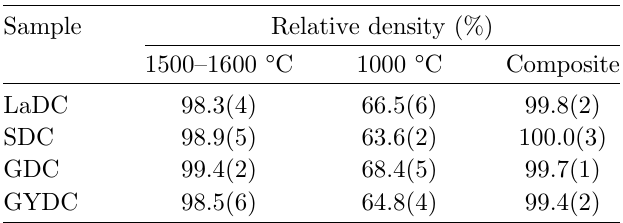
Table 3. RDC and RDC composite heat treatment temperatures and relative